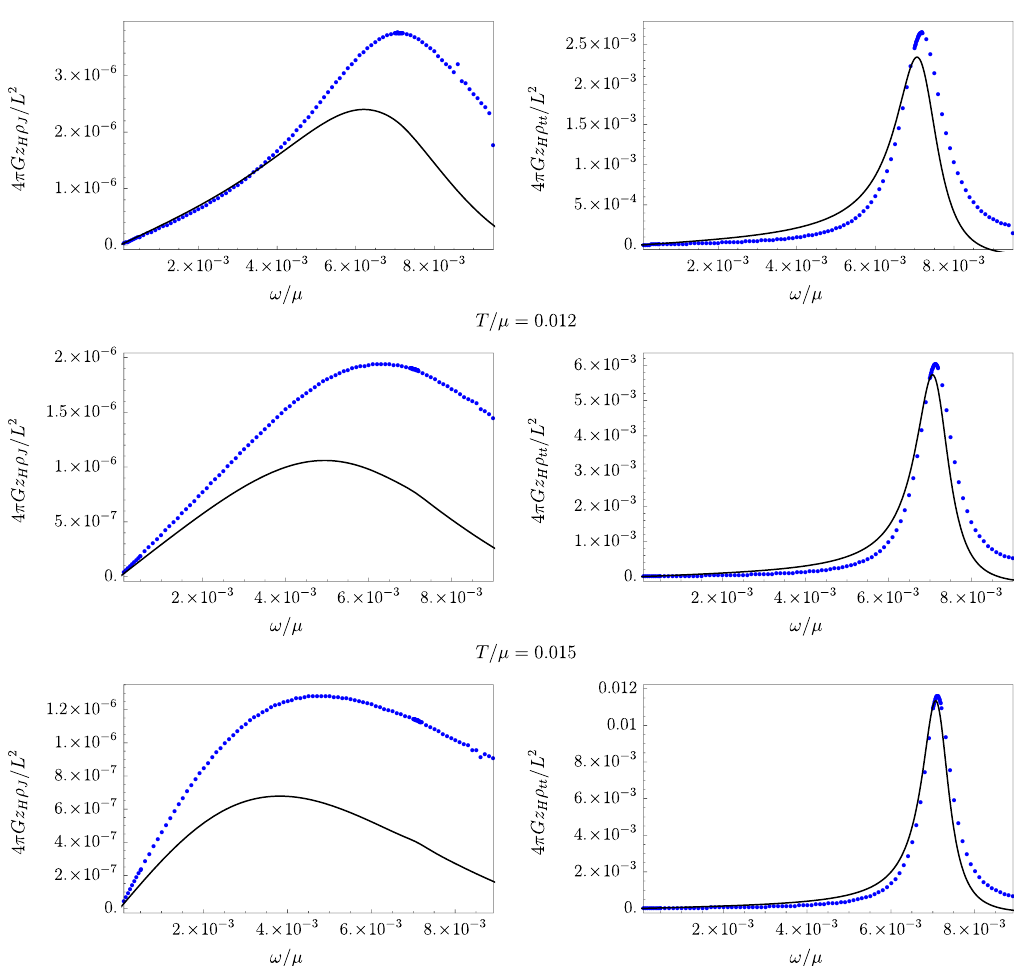
Figure 16. Our numerical results (blue dots) for the charge spectral function, (cid:26) J (left column) and energy spectral function, (cid:26) tt (right column), each made dimensionless by a factor of 4 (cid:25)Gz H =L 2 , as functions of !=(cid:22) for (cid:28) = 10 (cid:0) 4 , ~ (cid:11) = 0 : 3, k=(cid:22) = 10 (cid:0) 2 and T=(cid:22) = 1 : 1 (cid:2) 10 (cid:0) 2 (top row), 1 : 2 (cid:2) 10 (cid:0) 2 (middle row), and 1 : 5 (cid:2) 10 (cid:0) 2 (bottom row). The solid black lines come from the sum-of-poles approximation to the Green’s functions in eq. (3.6). As T=(cid:22) increases, the behaviors of both (cid:26) J and (cid:26) tt are qualitatively the same as the ~ (cid:11) = 1 cases in (cid:12)gures 12 to 15: in (cid:26) J the sound peak shrinks while the charge di(cid:11)usion peak grows, and in (cid:26) tt the only signi(cid:12)cant feature is a sound peak that grows. Most importantly, for this smaller ~ (cid:11) the crossover can still be de(cid:12)ned as the value of T=(cid:22) where the charge di(cid:11)usion and sound peaks in (cid:26) J have equal height [33].